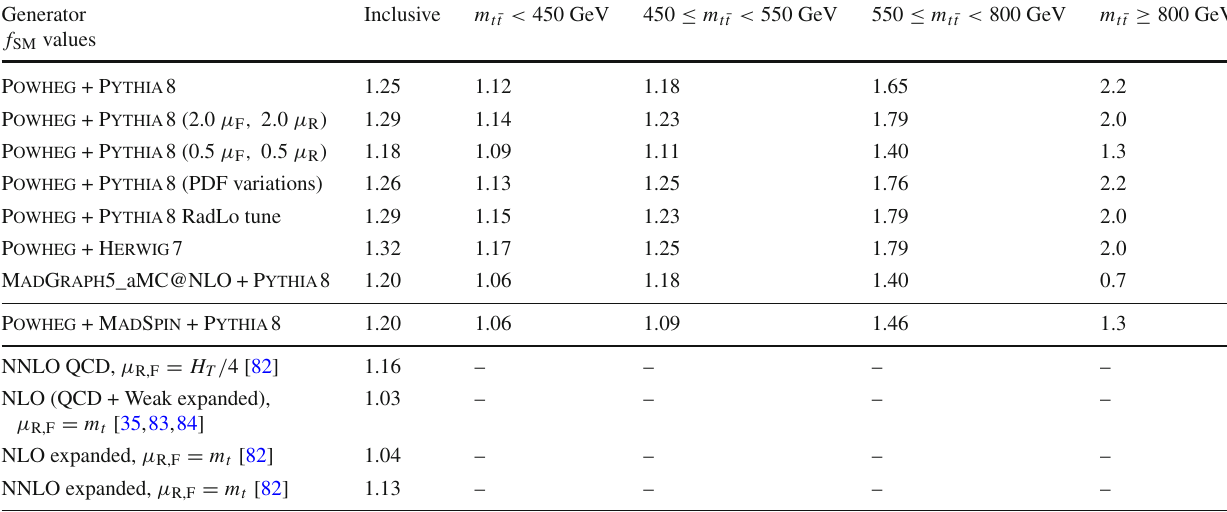
Table 7 Summary of the extracted spin correlation values in the inclusive (cid:3)φ observable using different hypothesis templates